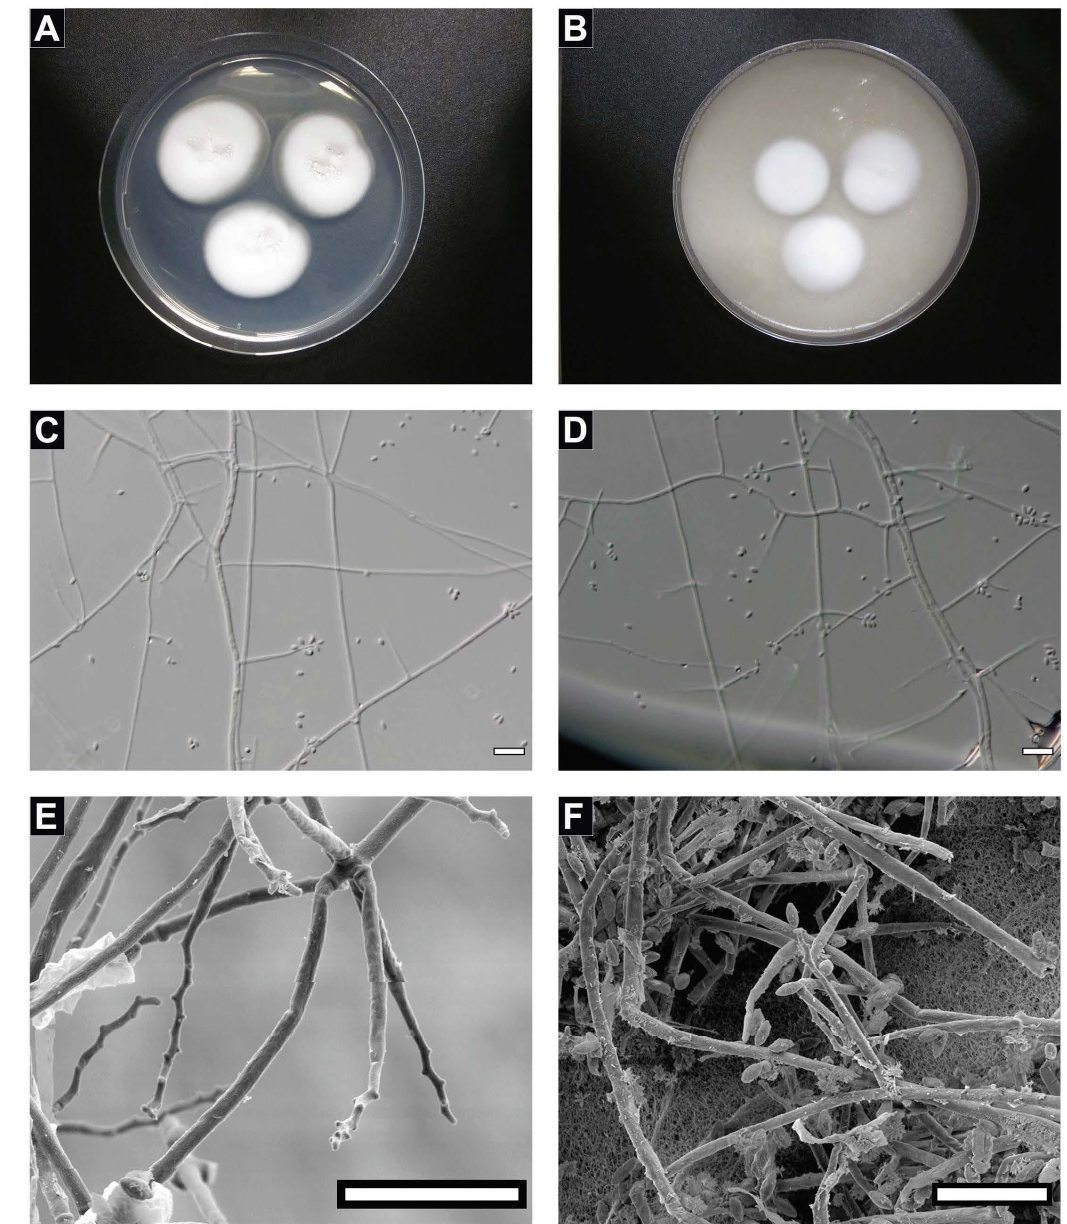
Figure 1. Macro and micromorphology of Parengyodontium torokii . Colony surface of FJ11-L10- SW-P1 after 21 days of incubation at room temperature (23 °C) in standard 9 cm petri dishes on ( A ) PDA media and ( B ) OMA media. ( C ) Conidia produced at each bent point of the zigzag rachides of the fertile conidiogenous cells. ( D ) Whorl of two conidiogenus cells with conidia attached at the zigzag rachides. Scale Bars ( C – E ) = 20 µ m. ( E ) Scanning electron microscopy images of Parengy- odontium torokii from ex-type strain FJ11-L10-SW-P1 with whorl of conidiogenous cells showing butt-shaped denticles and ( F ) subcylindrical to ellipsoidal, hyaline single-celled conidia. Scale bar for all microscopy is 10 µ